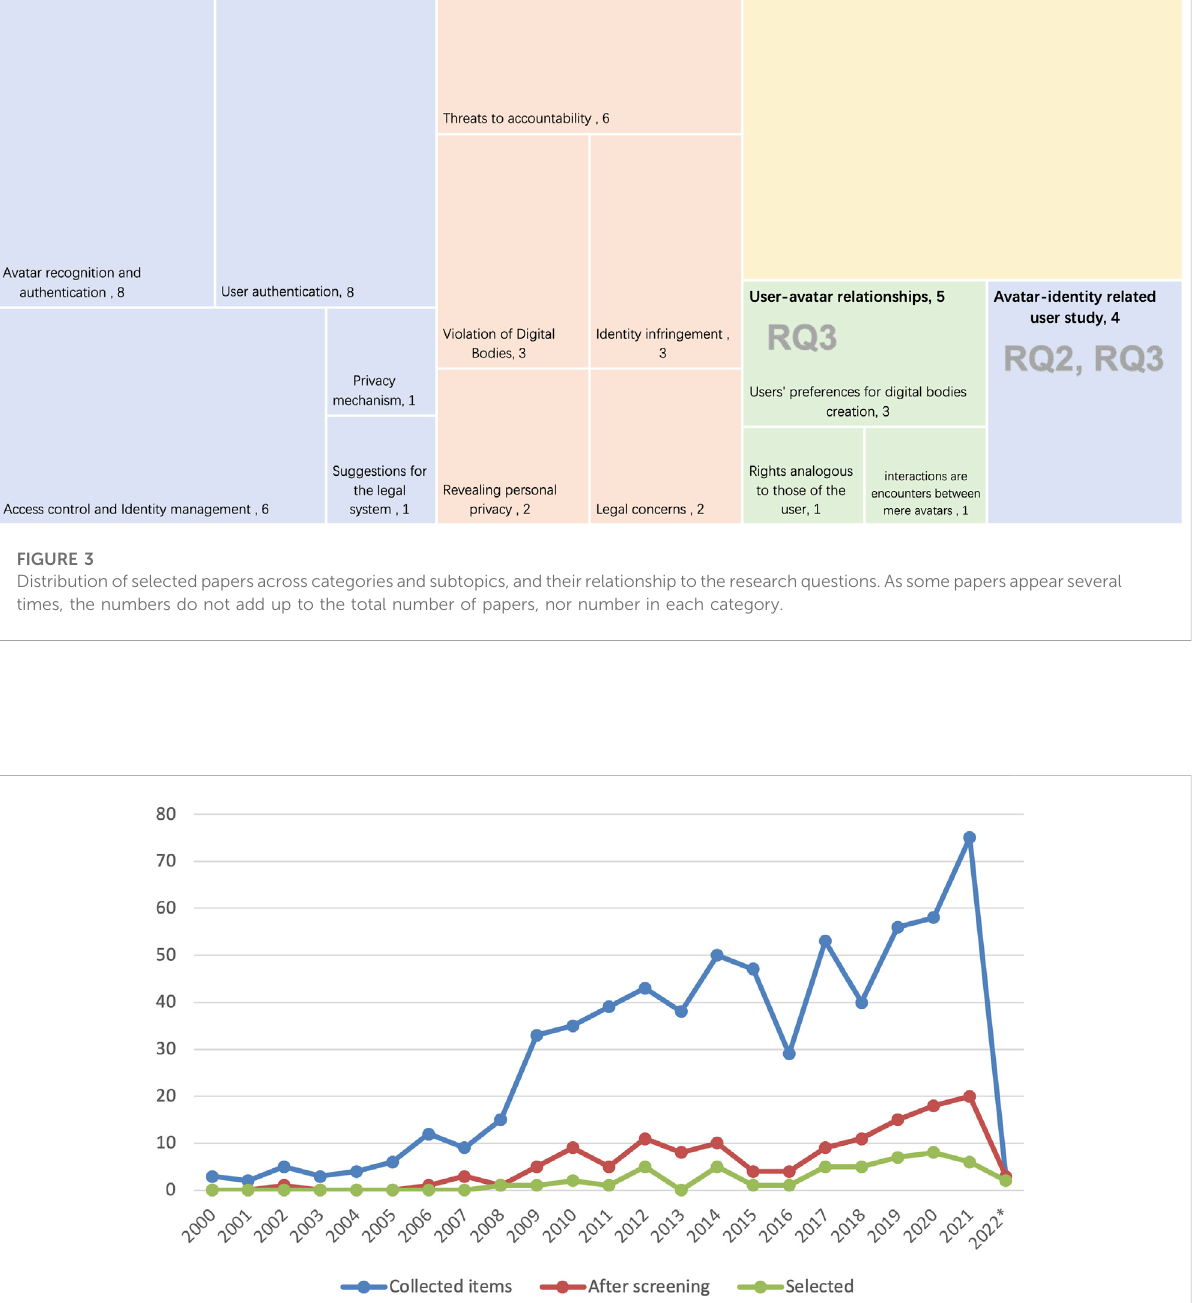
Frontiers in Virtual